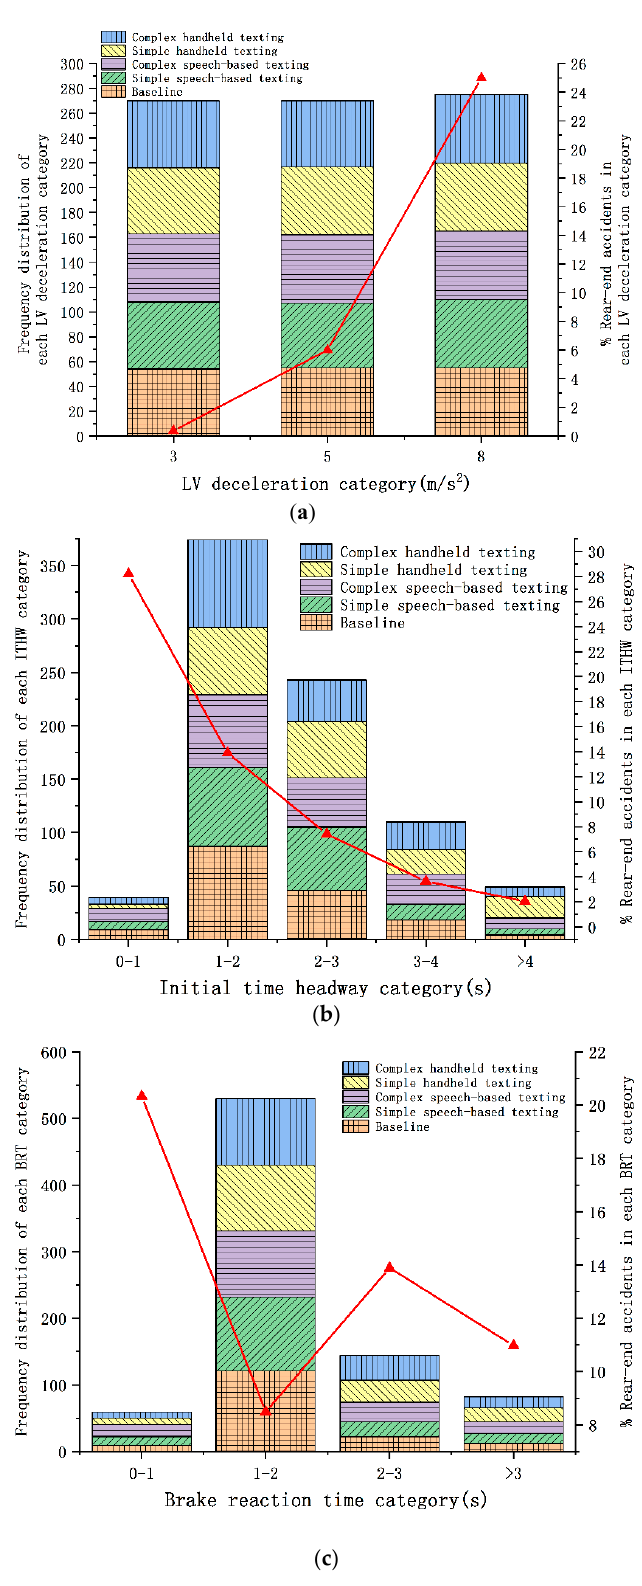
Figure 5. Frequency distributions of BRT, ITHW, and LV deceleration categories with the percentage of observed accidents in di ff erent driving conditions. ( a ) LV deceleration category; ( b ) ITHW category; ( c ) BRT